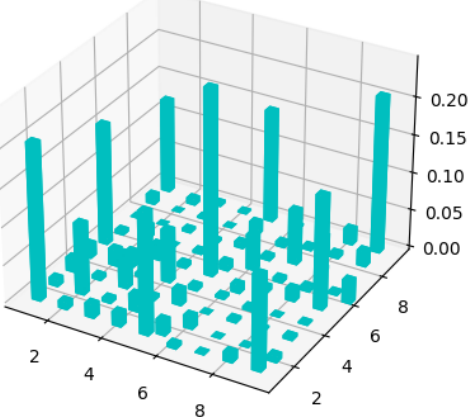
Figure 5. Density matrix when α = 0.5.